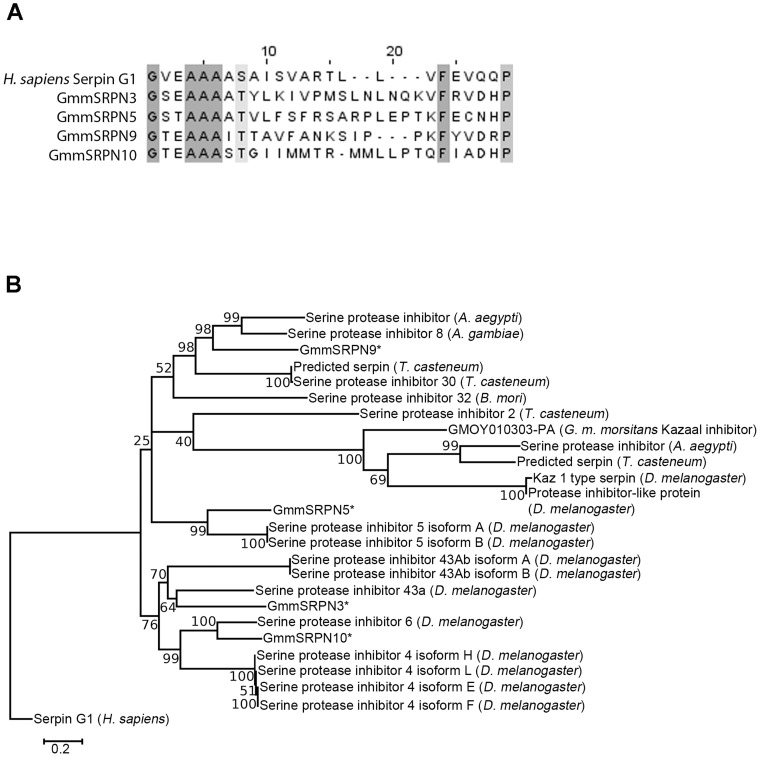
Putative tsetse midgut serpins show active site conservation with human complement cascade inhibitory serpin, but may not have evolved as a consequence of a haematophagous lifestyle.(A) Clustal-W alignment the putative tsetse serpins RCL region (GmmSRPN3, GmmSRPN5, GmmSRPN9, GmmSRPN10) with human SerpinG1 complement cascade inhibitor indicate conserved (highlighted in grey) key residues involved in the inactivation of serine proteases. (B) A phylogenetic tree (with bootstrap values shown) generated from neighbour-joining alignment of putative tsetse midgut serpins (denoted with *) and representative serpins from arthropod species with fully sequenced genomes (Aedes aegypti, Anopheles gambiae, Apis mellifera, Bombyx mori, Drosophila melanogaster and Tribolium castaneum). Distinct clustering of these putative midgut serpins with that of haematophagous species (Aedes aegypti, Anopheles gambiae) was not apparent, suggesting that the serpins may have either evolved following speciation of Glossina morsitans morsitans or from the last common arthropod ancestor.